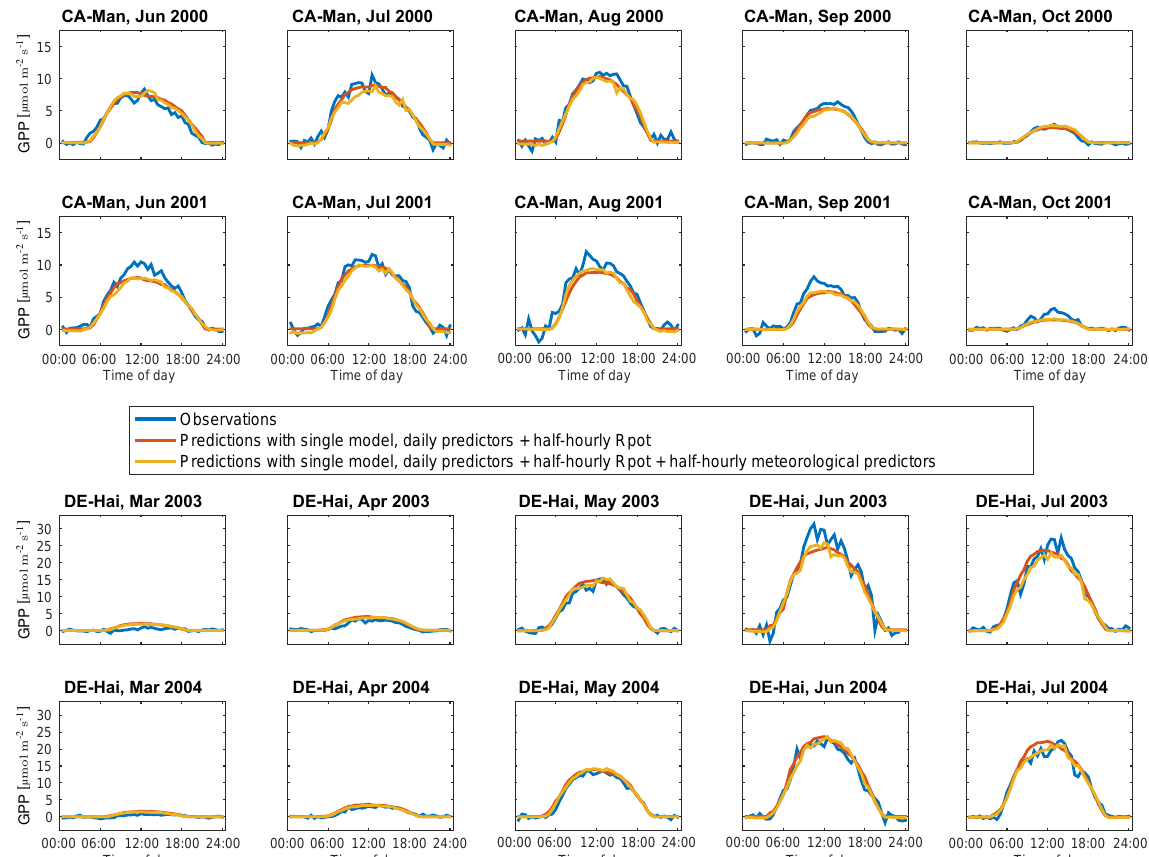
Figure 7. Some example sites with average diurnal cycles for different months comparing two prediction approaches with the observations.